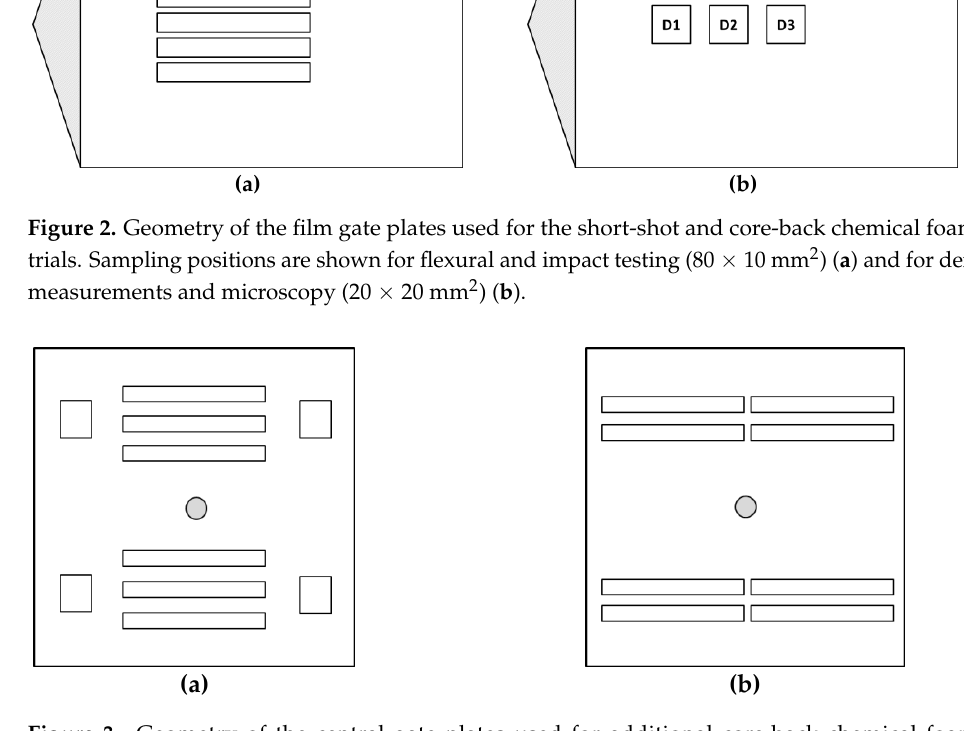
Figure 3. Geometry of the central gate plates used for additional core-back chemical foaming trials. Sampling positions are shown for flexural testing (80 × 10 mm²) and density measurements (20 × 20 mm²) ( a ) and for impact testing (80 × 10 mm²) ( b ).